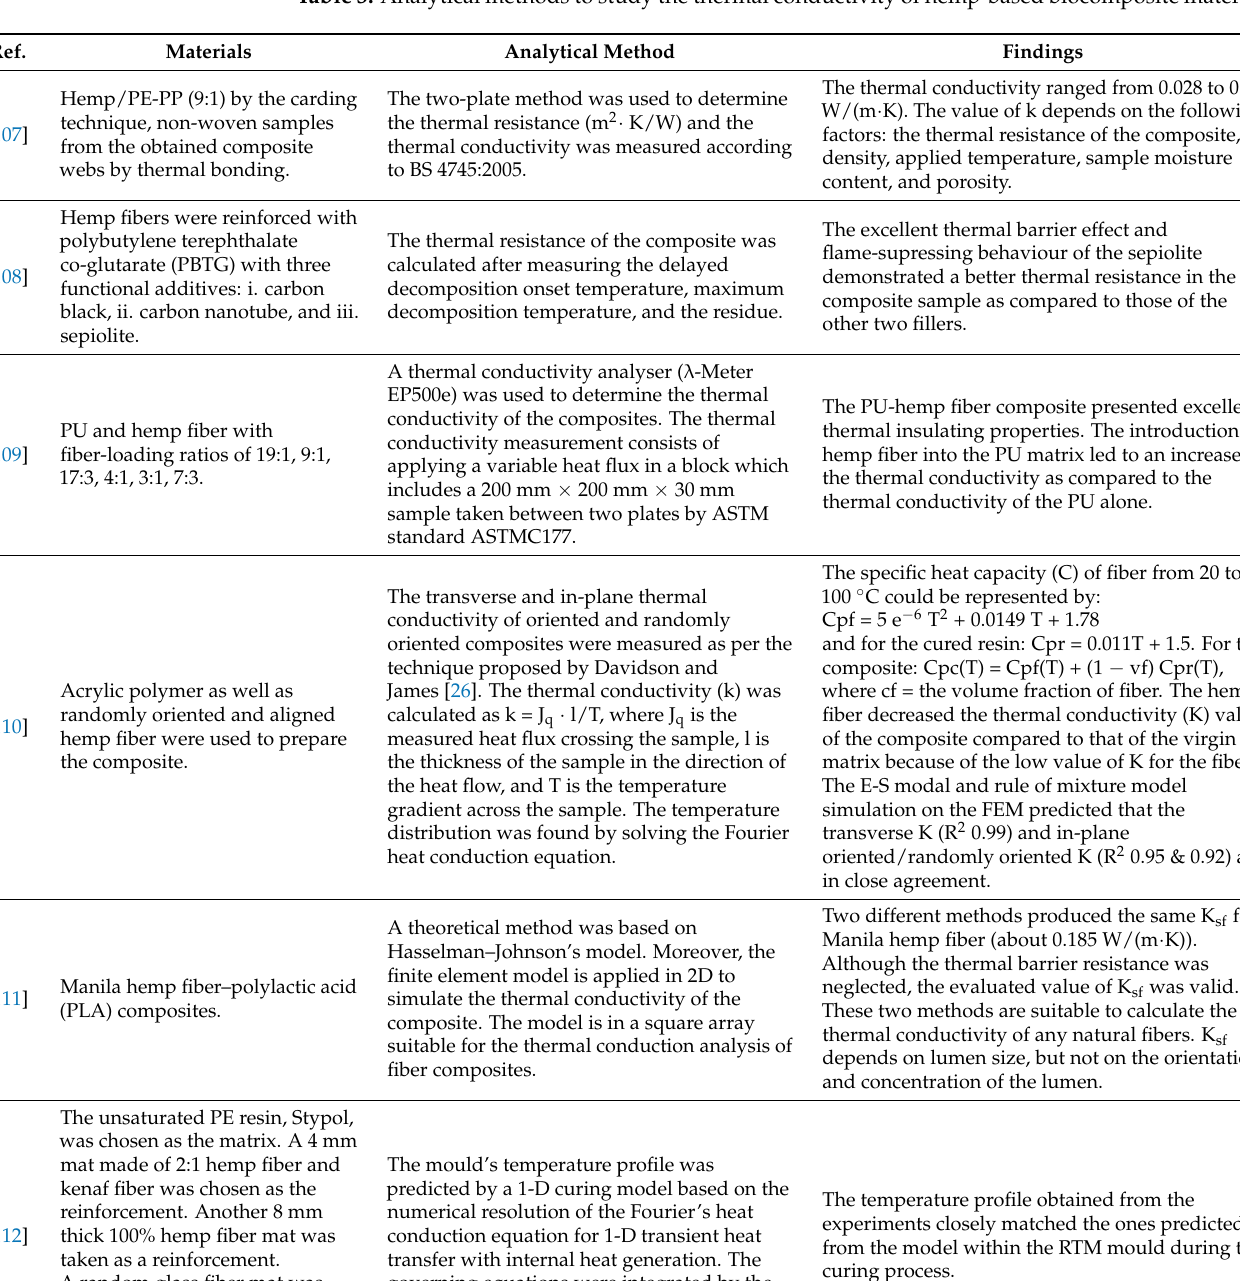
Table 3. Analytical methods to study the thermal conductivity of hemp-based biocomposite